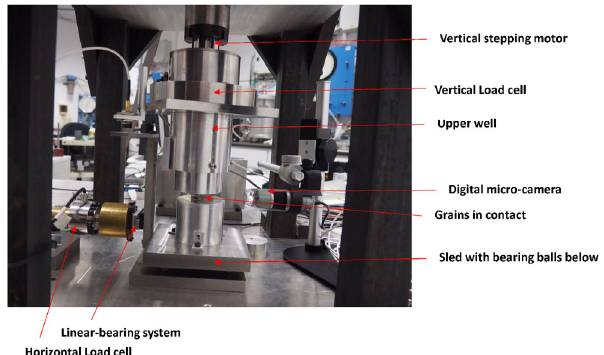
Fig. 2 A close view of the new large-size micromechanical inter- granule loading apparatus at City University of Hong Kong during an